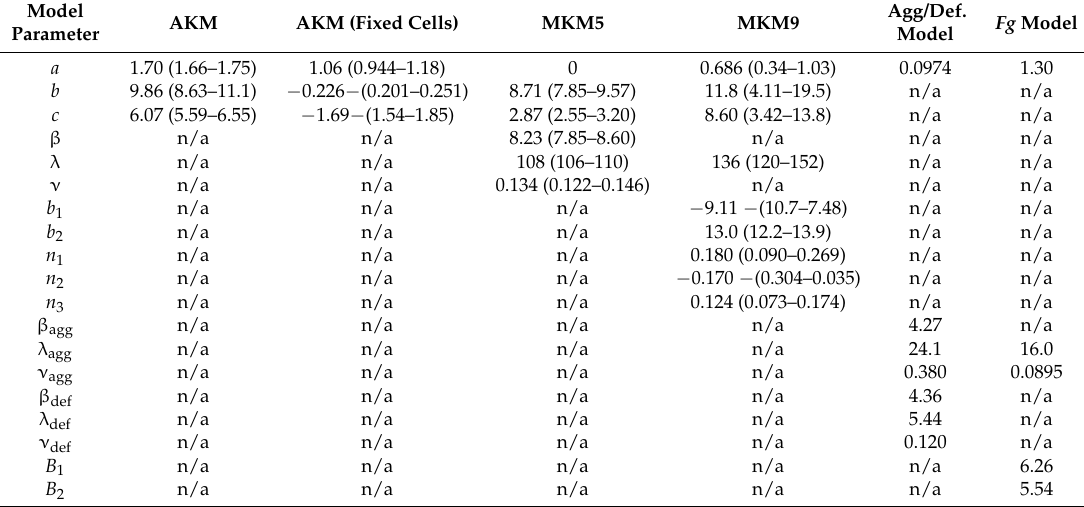
Table 3. The best fit parameters for the three modified Krieger models with 95% confidence intervals for the parameters as determined from Monte Carlo